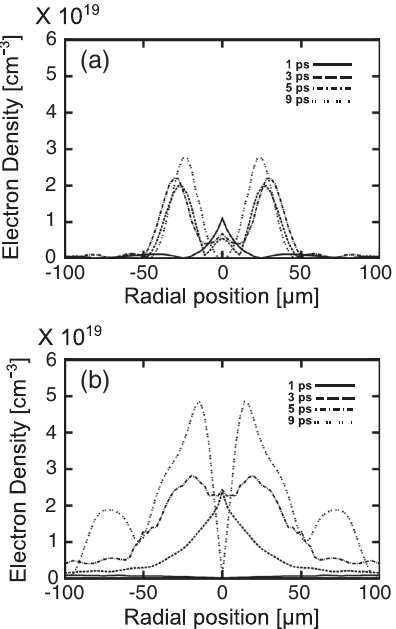
FIG. 14. Transverse density profiles of the plasma channels at the pulse duration of 0.3 ps for different times. (a) Electron density distribution at the entrance of the plasma channel. (b) Electron density distribution at the channel